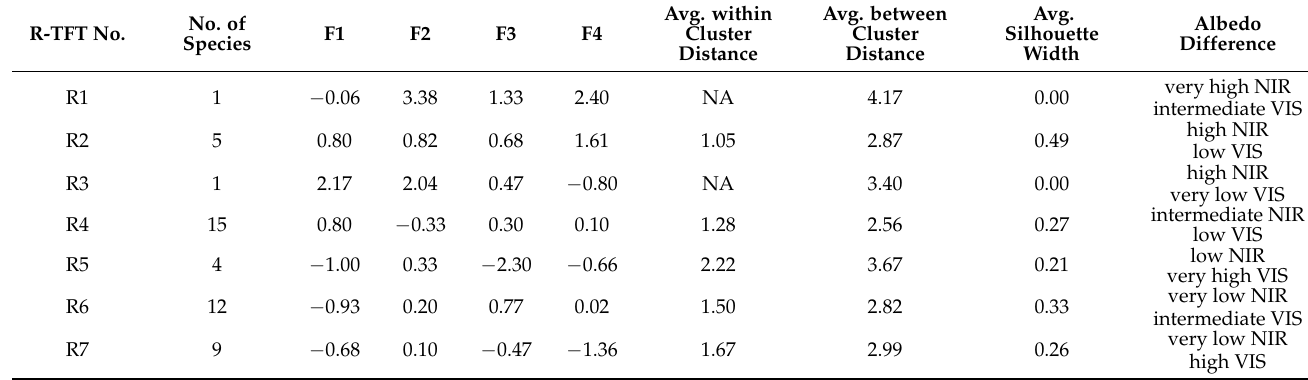
Table 4. Cluster properties and quality metrics of TFTs influencing radiation partitioning between leaves and atmosphere (R-TFT). The TFTs were described according to average species factor scores for F1–F4. R-TFT size is the number of species assigned to the respective TFT. Bold values of silhouette width represent moderately well-separated and compact clusters. The average within cluster distance could not be calculated for R1 and R3, as they only consist of one species. R-TFT